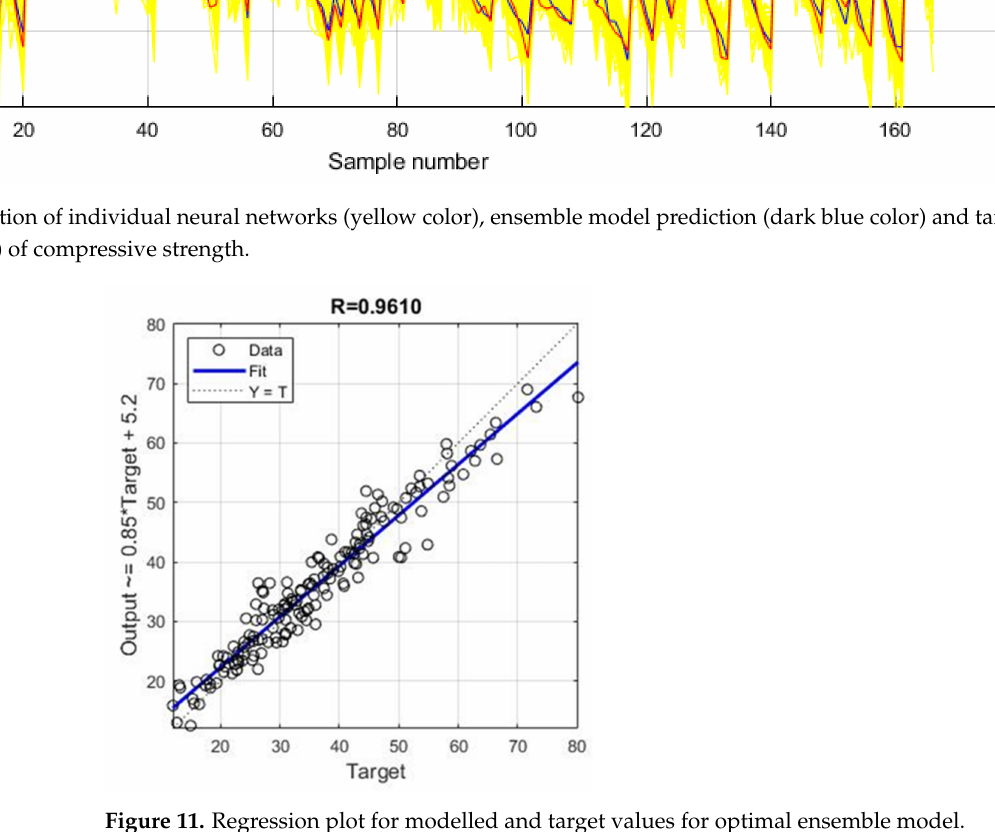
Figure 11. Regression plot for modelled and target values for optimal ensemble